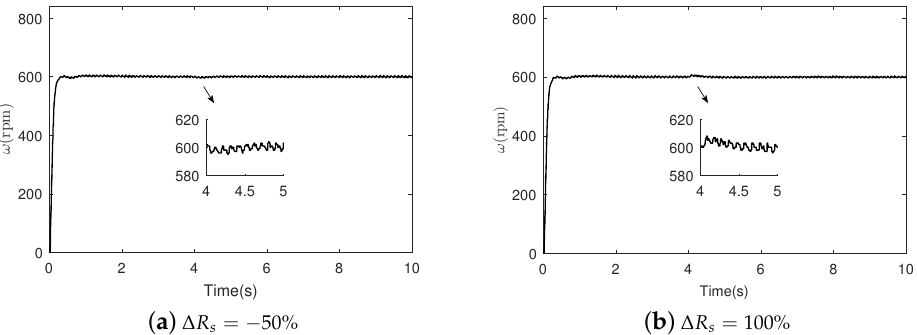
Figure 10. Speed response curves when the stator resistance value changes suddenly.